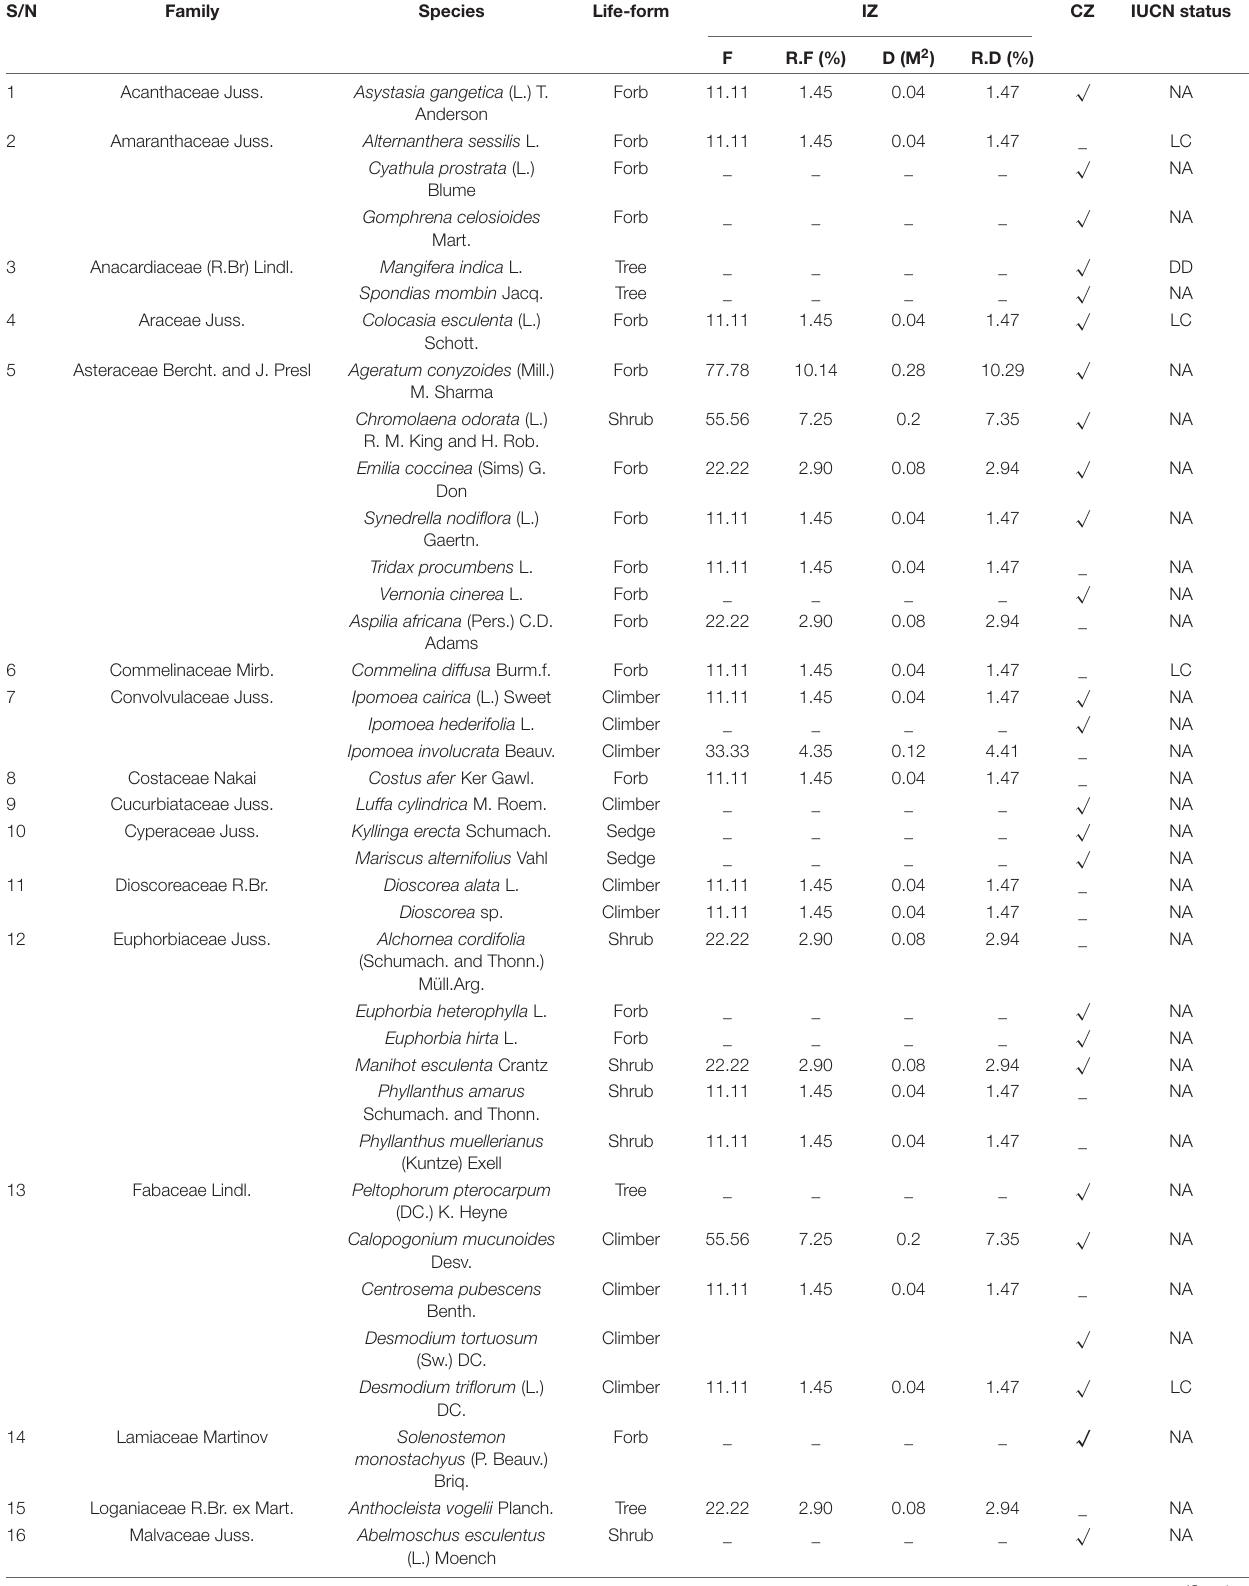
TABLE 2 | Species diversity, occurrence, and conservation status in the study